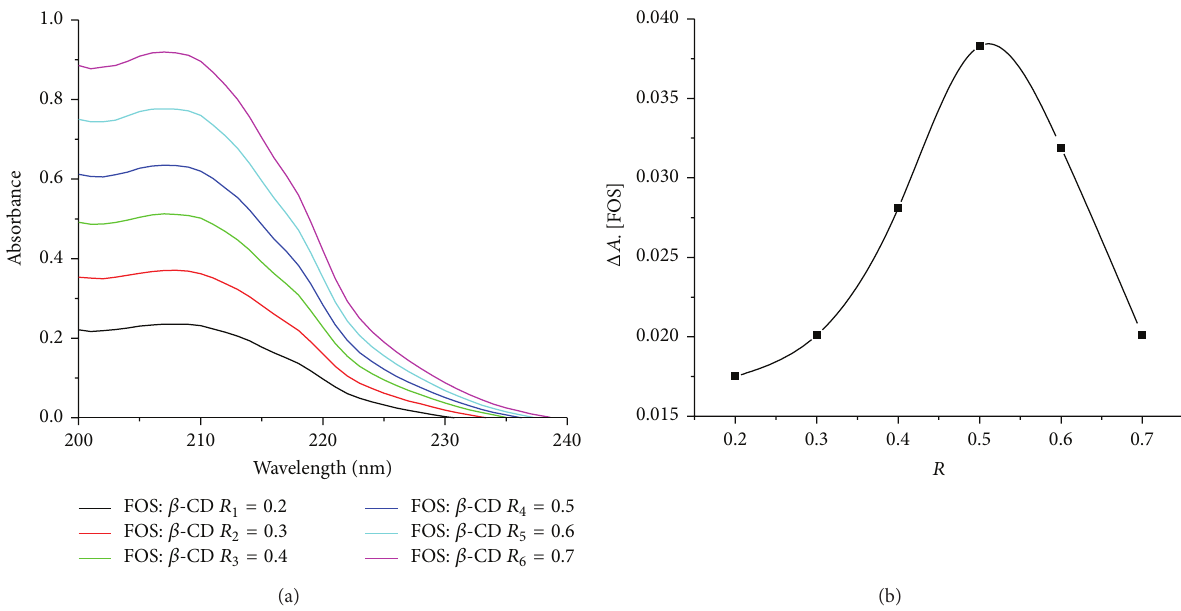
Figure 2: (a) UV spectra of aqueous solution of FOS and 𝛽 -CD mixed in variable molar ratio 𝑅 ; (b) Job’s plot for different molar ratios of FOS and 𝛽 -CD from absorbance